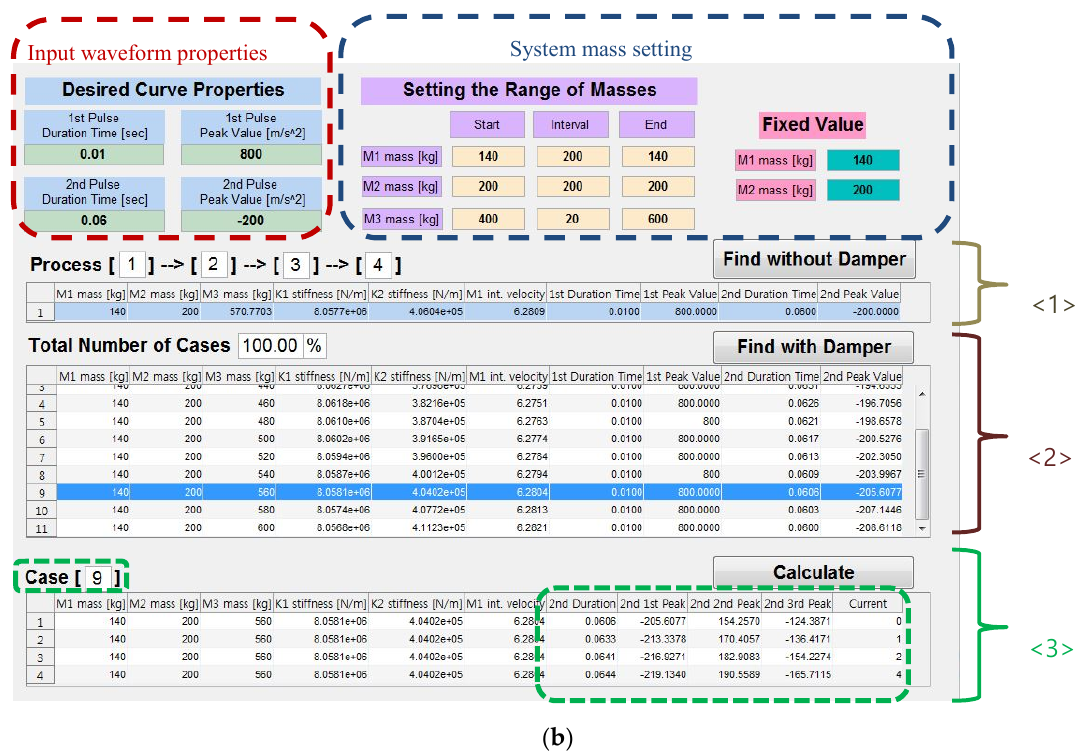
Figure 12. GUI of the waveform prediction simulator program: ( a )Flow chart; ( b ) GUI program.